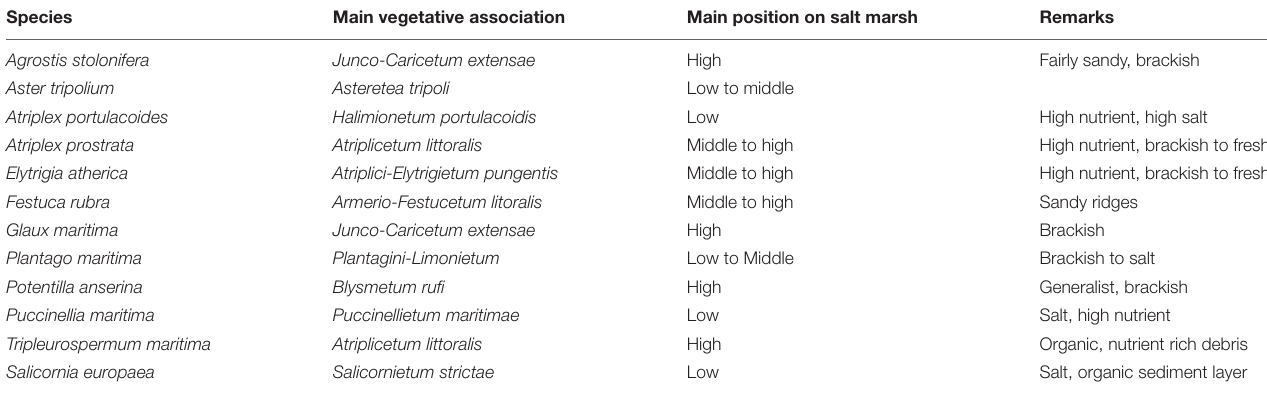
TABLE 1 | Overview of the ecological position on the salt marsh of the species